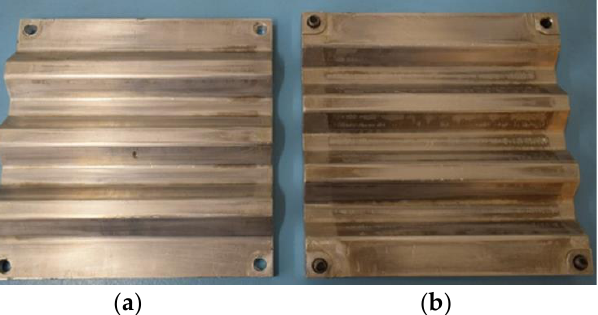
Figure 15. Compression Dies, ( a ) top half with alignment holes, ( b ) bottom half with dowel